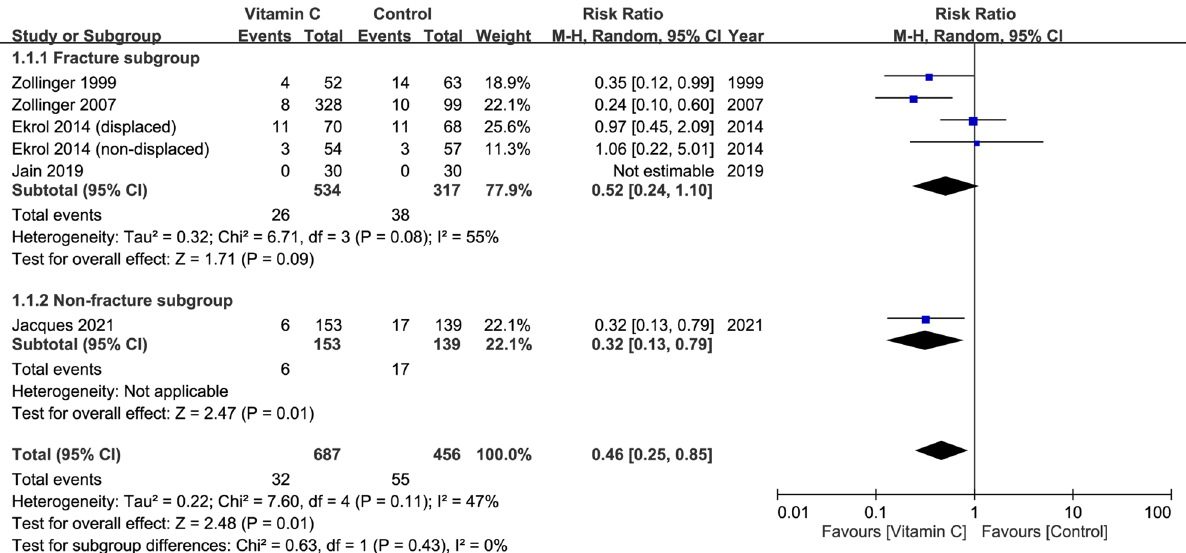
Figure 5. Forest plot for the comparison of risk of complex regional pain syndrome I between vitamin C and placebo groups at follow-up of 12 months. CI, confidence interval; M–H, Mantel–Haenszel.